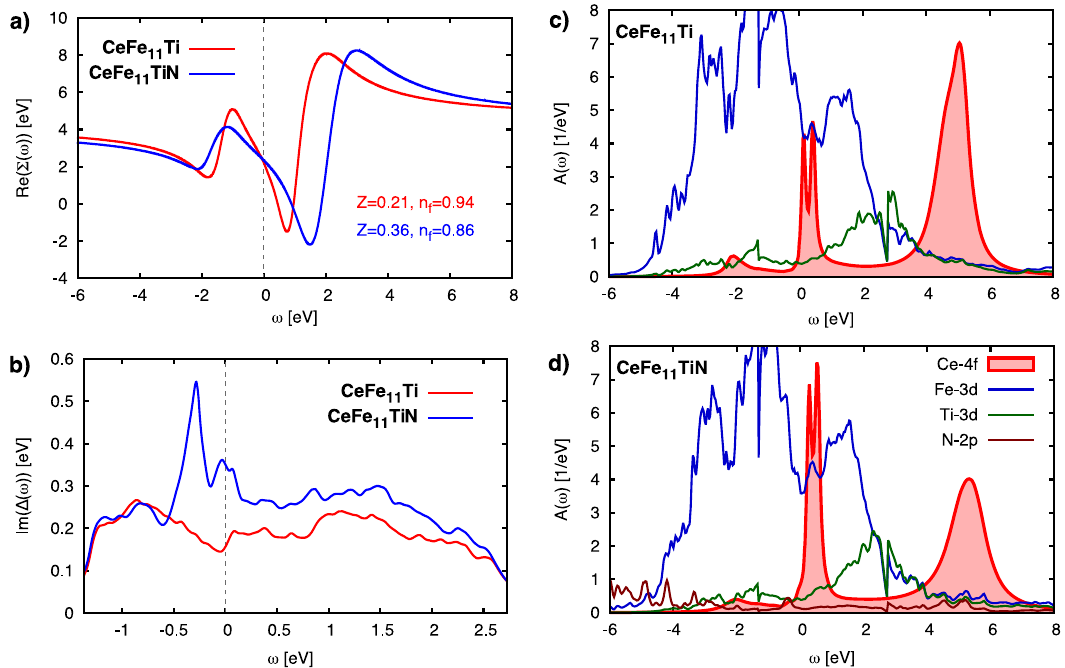
Fig. 3 Impact of nitrogenation on electronic correlations and spectral function of CeFe 11 Ti. a Real part of the self-energy Σ ( ω ) in CeFe 11 Ti (in red) and CeFe 11 TiN (in blue). The quasiparticle weight Z and Ce-4 f shell occupation n f are also indicated in the corresponding colors. b Imaginary part of the hybridization function Δ ( ω ). In particular, at the Fermi energy Im Δ ( ω ) is considerably larger in the nitrogenated compound. (The self-energies ( a ) and hybridization functions ( b ) are averaged over the six orbital contributions with the largest occupation number, respectively. For orbital-resolved self-energies, we refer the reader to the Supplementary Fig. 3.) c , d Corresponding spectral functions. The Ce-4 f Kondo peak at the Fermi energy is more pronounced in CeFe 11 TiN due to the more delocalized character of its Ce-4 f electrons. For completeness, also the Fe-3 d , Ti-3 d , and N-2 p states are shown (the Fe-3 d contribution has been rescaled by a factor